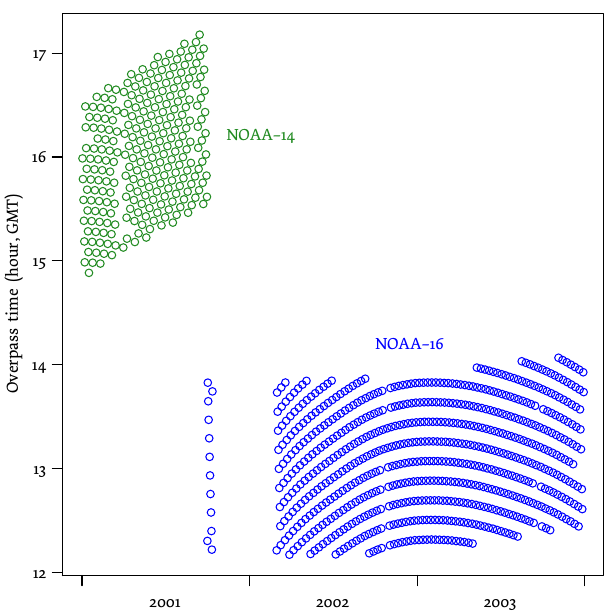
Fig. 5. Overpass times of the NOAA AVHRR platforms utilised for the daily LST maps at the centre of the Elbe River basin. Local solar time is about UTC + 50min. The switch from NOAA-14 to NOAA-16 clearly shifted the bandwidth of scan times from late af- ternoon towards noon. Calculated from satellite Equator crossing data available via URL http://www.noaasis.noaa.gov/NOAASIS/ ml/navigation.html (last access: May 2012).